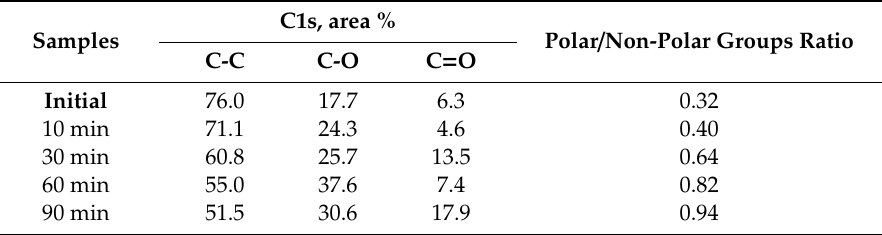
Table 2. Concentrations of polar / non-polar